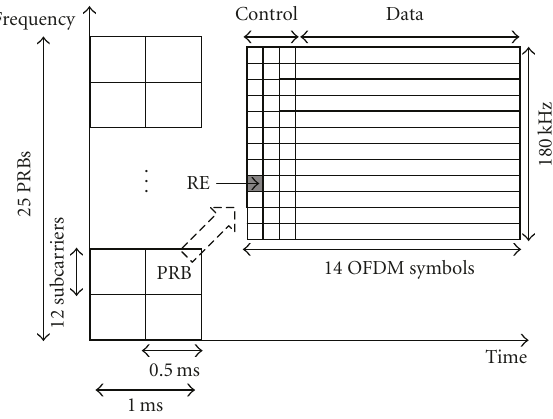
Figure 1: Time-frequency resource structure of